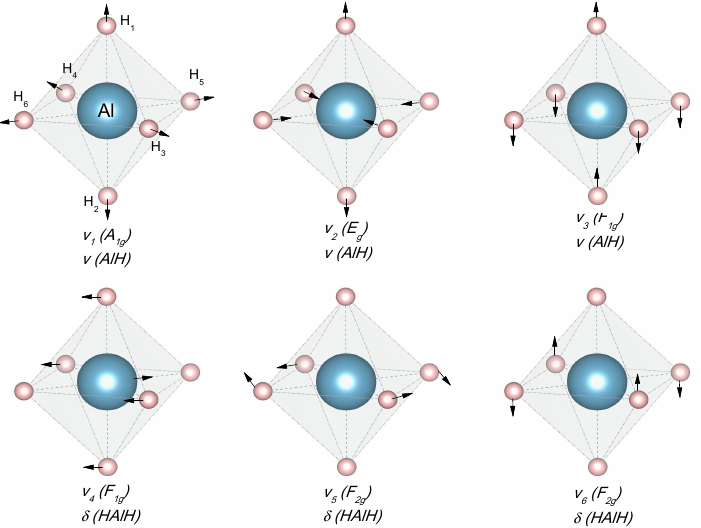
Figure 28. Normal modes of vibration of octahedral [AlH 6 ] 3 − . Adapted from reference [302]. The vibrational spectra of alanates are frequently classified as external and internal. The external vibrations are due to the vibration of the whole crystal structure. Meanwhile, the internal vibrations are due to the [AlH 4 ] − ion, which has four active vibrational modes in Raman and only two in infrared [303]. Some of these features are shared with other materials of similar structure, for example, the borohydrides [304]. The infrared active modes of the [AlH 4 ] − ion are the asymmetric stretching modes in the region 1600–2000 cm − 1 and the bending modes in the region 700–900 cm − 1 [305]. Some representative data are collected in Tables 19 and 20. As a generally accepted trend of infrared vibrations in the alanates of group 1, the stretching modes, in wavenumbers, roughly decrease with increasing mass of the cation [306]. Meanwhile, the bending modes are unaffected by the counter-ion [305,306]. Other correlations between the stretching and bending peaks (or regions) versus ionization energy, electronegativities, or bond distance have been proposed [302]. Indeed, we tried to find